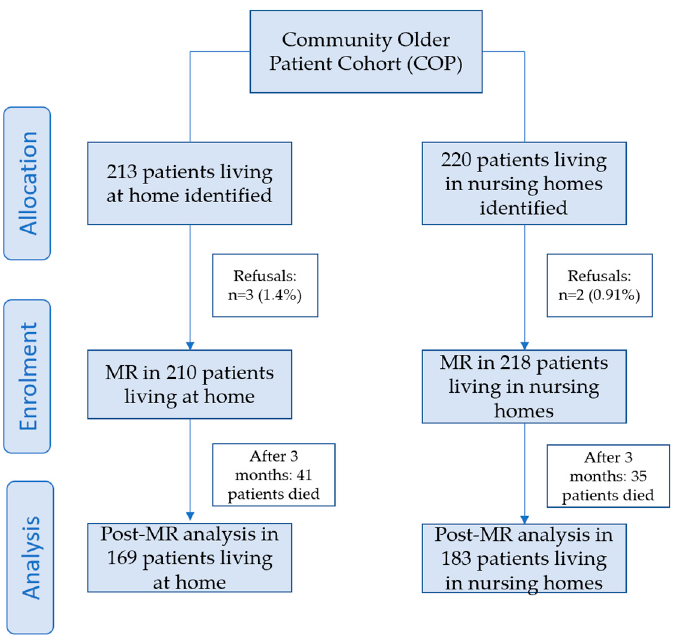
Figure 2. Number of patients pre- and post-medication review according to their place of resi- dence.